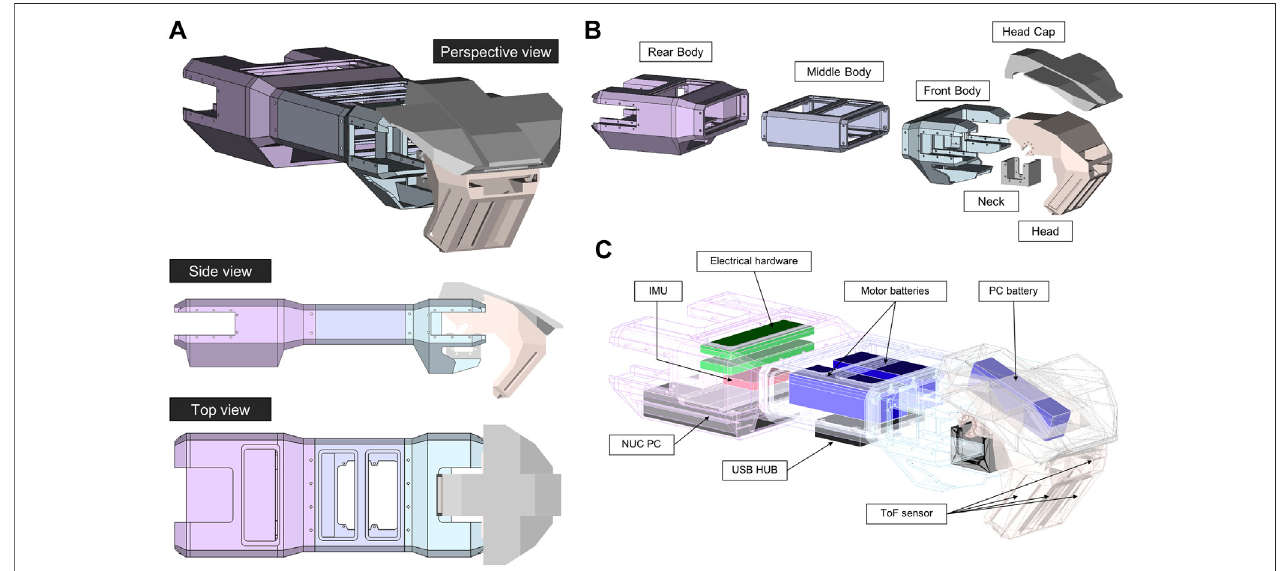
FIGURE 2 | The robot body (torso and head). (A) Orthographic projections. (B) Interior hardware placements. (C) Exploded parts.